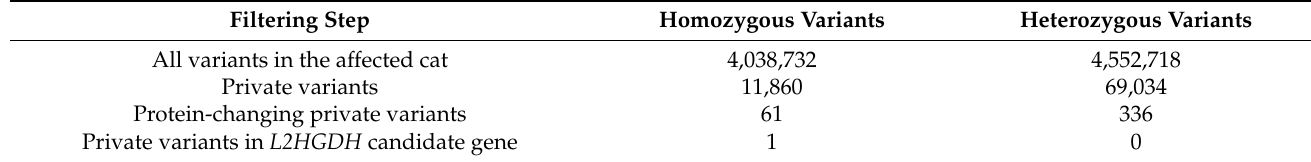
Table 1. Results of variant filtering in the affected cat against 48 control